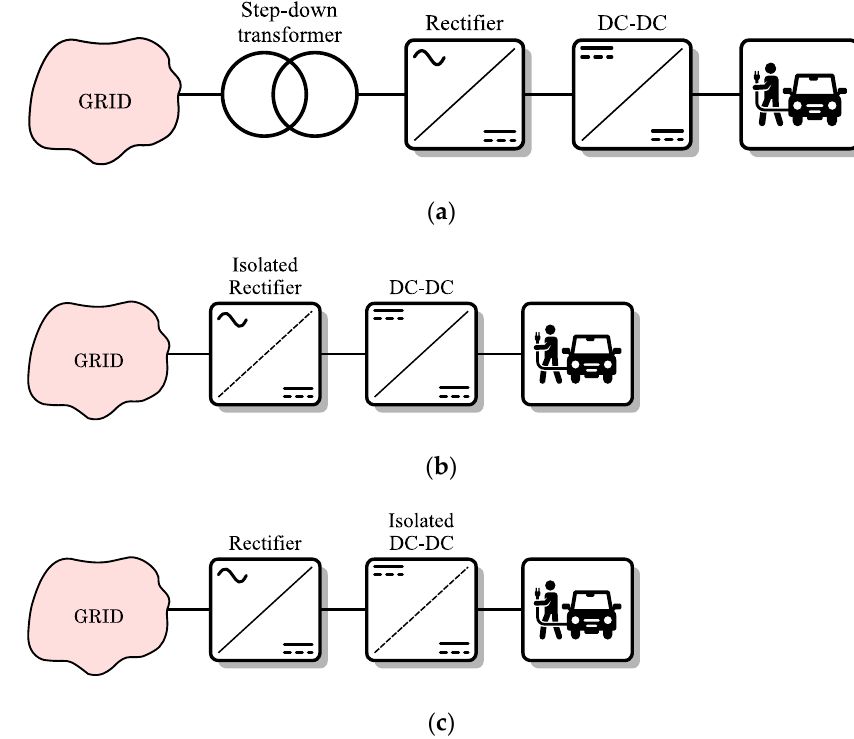
Figure 1. Simplified single-wire diagram of different electric vehicle (EV) fast charging station solutions. ( a ) Galvanic isolation is provided by a line frequency transformer; ( b ) Galvanic isolation is provided by the AC-DC rectifier; ( c ) Galvanic isolation is provided by the DC-DC charging unit.